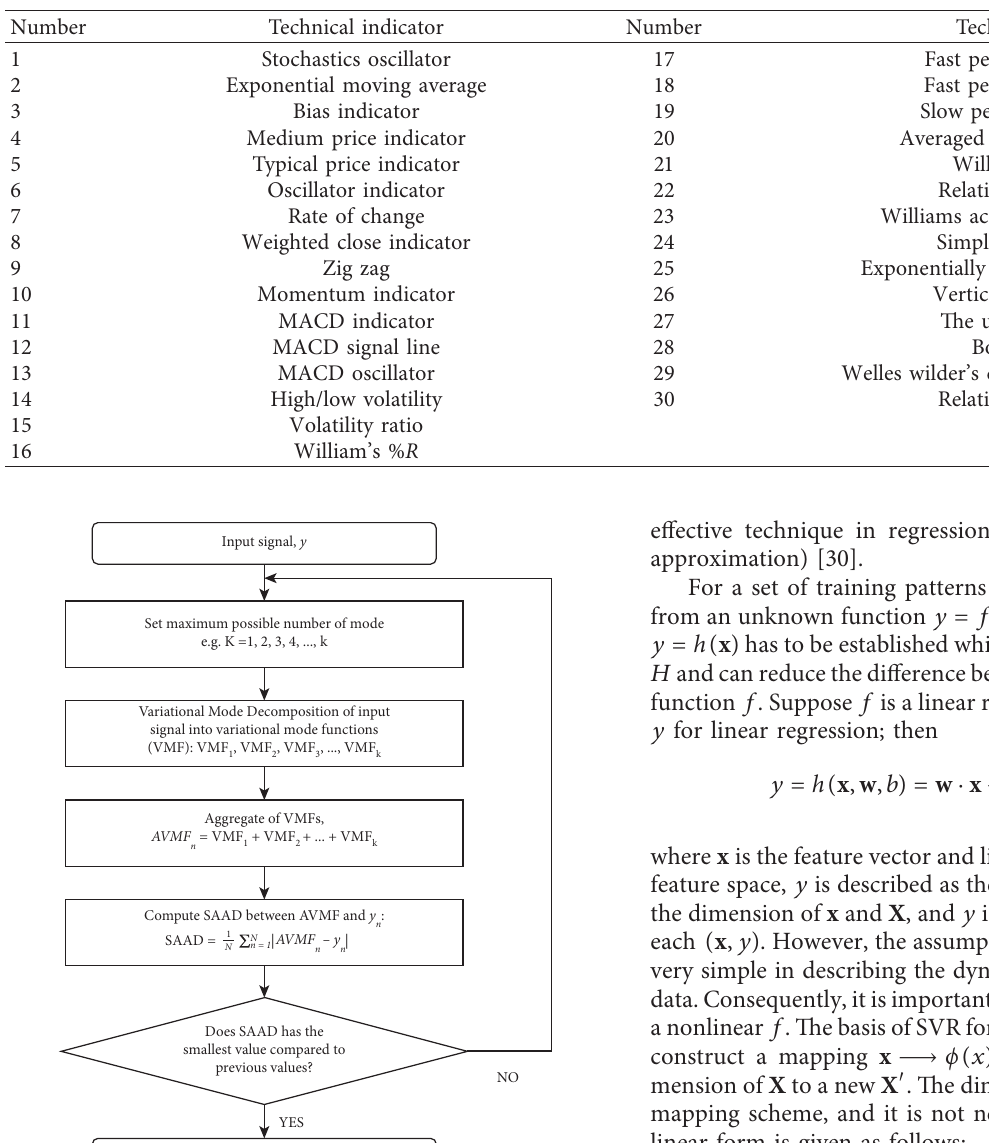
Table 1: Technical indicators.